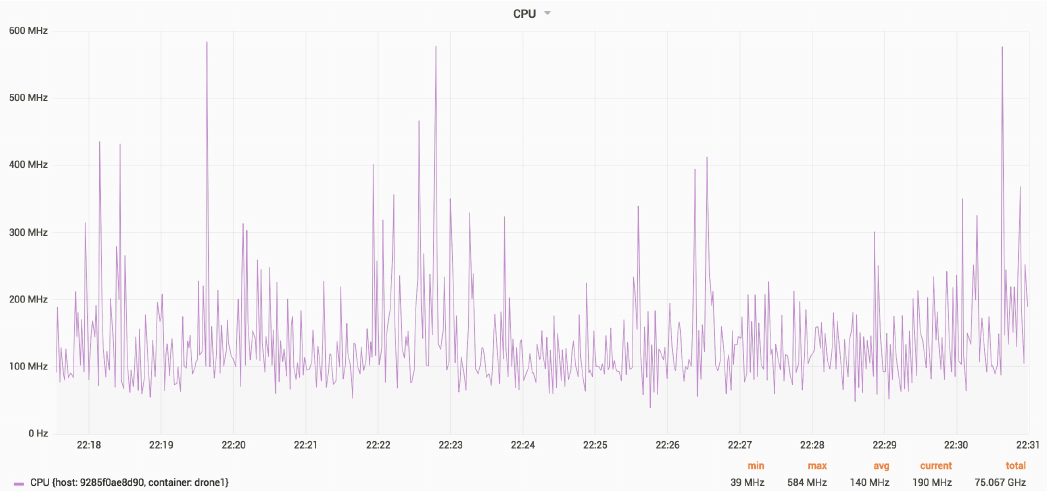
Figure 24. CPU usage for a drone.